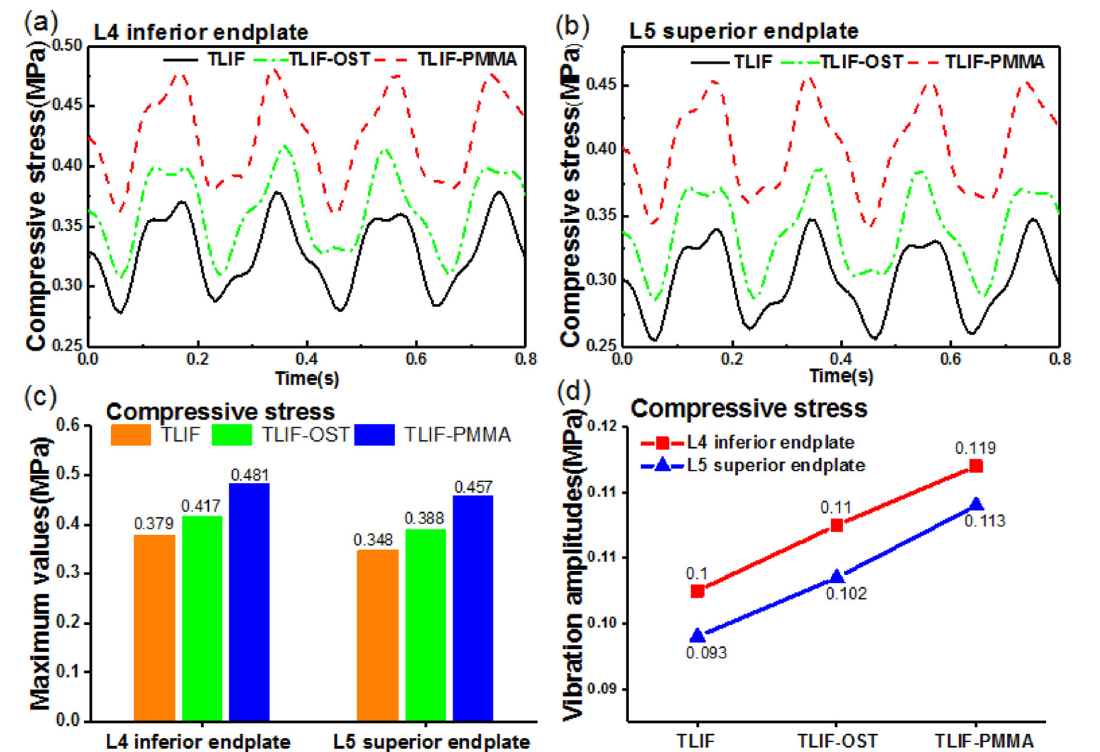
Fig. 8 The dynamic response of the compressive stress at the interface between cages and endplates for TLIF, TLIF-OST, and TLIF-PMMA models. The compressive stress in a the interface between cage and L4